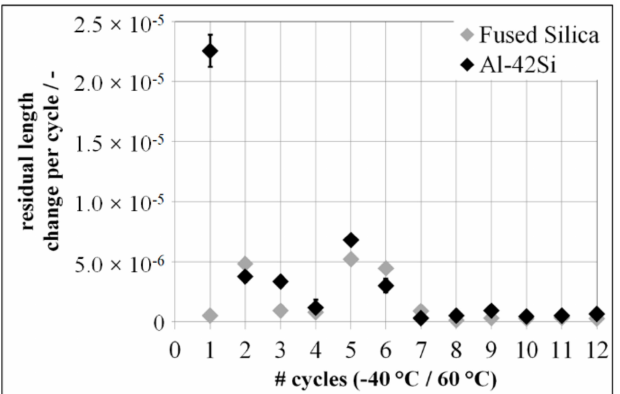
Figure 5. Residual length change of Fused Silica and Al-42Si in a temperature range between − 40 ◦ C and 60 ◦